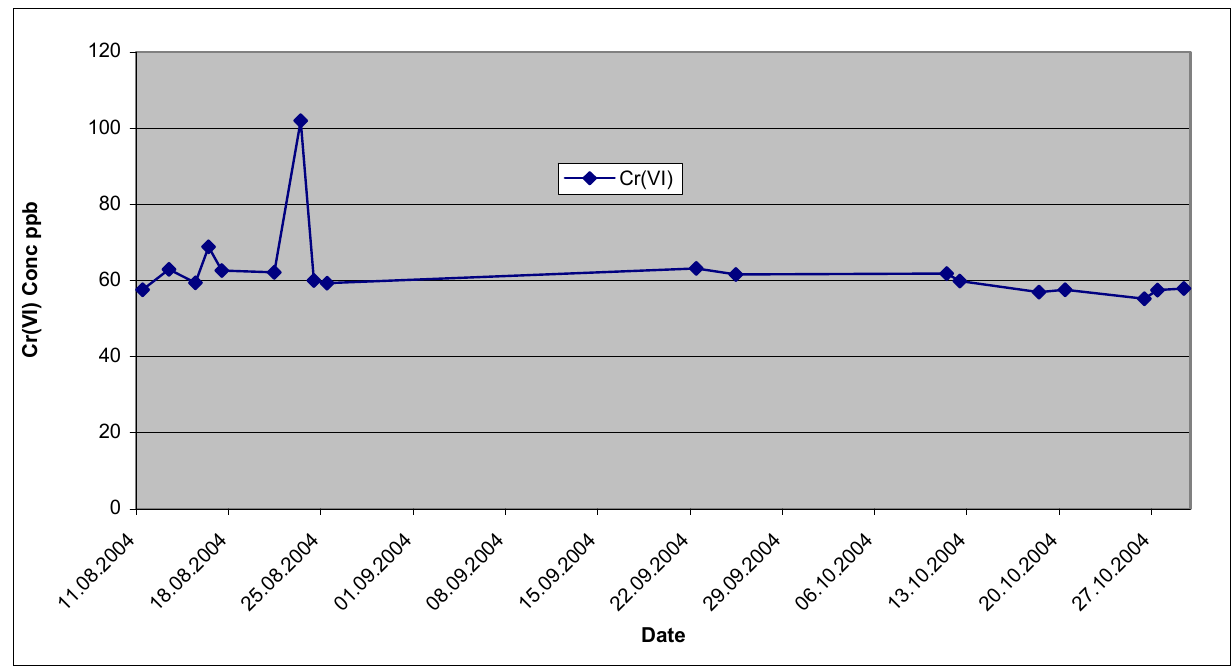
Figure 9. Results of mid-calibration standards August 11-October 29,